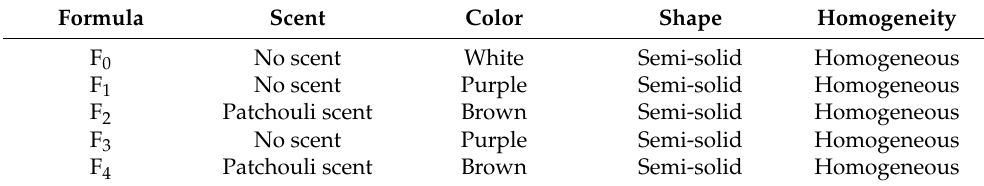
Table 6. Organoleptic properties of polyvinyl alcohol/corn starch/patchouli oil hydrogel films loaded with silver nanoparticles.